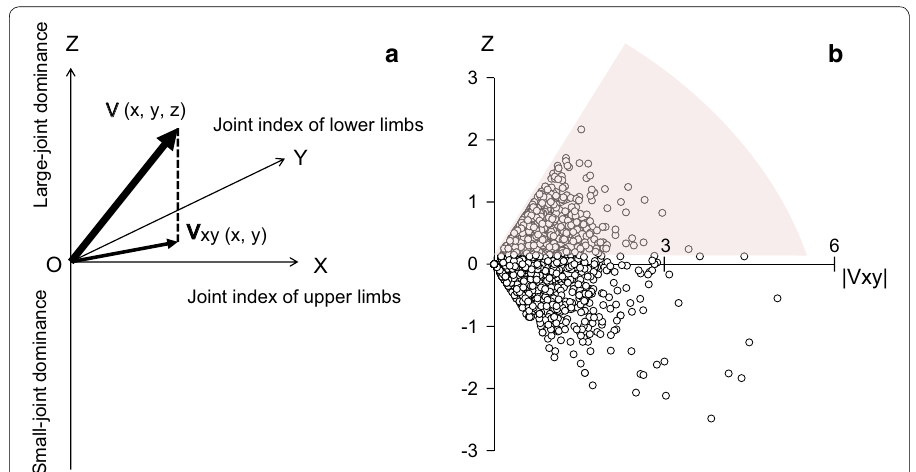
Fig. 1 Joint index vector. a Diagram for joint index vector V (x, y, z). Vector Vxy (x, y) is an orthographic projec- tion of the vector V (x, y, z) to the XY plane. b Scatter plots between |Vxy| and z. |Vxy| is the scalar of vector Vxy. Vectors of large-joint-dominant patients are distributed in the shaded area (z >